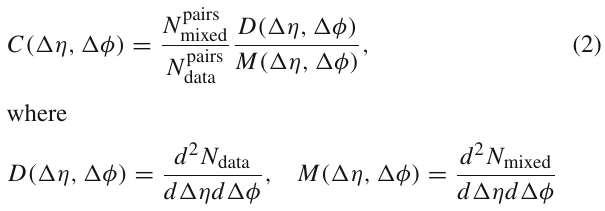
figure; its origin lies in the middle of VTPC-2, on the beam axis. The nominal beam direction is along the z axis. The magnetic field bends charged particle trajectories in the x – z (horizontal) plane. The drift direction in the TPCs is along the y (vertical)